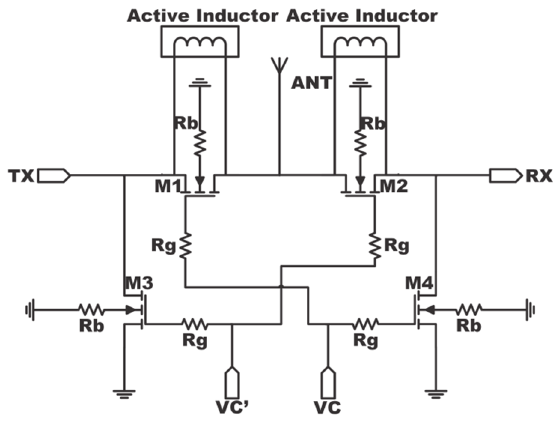
Figure 2 - Proposed T/R switch